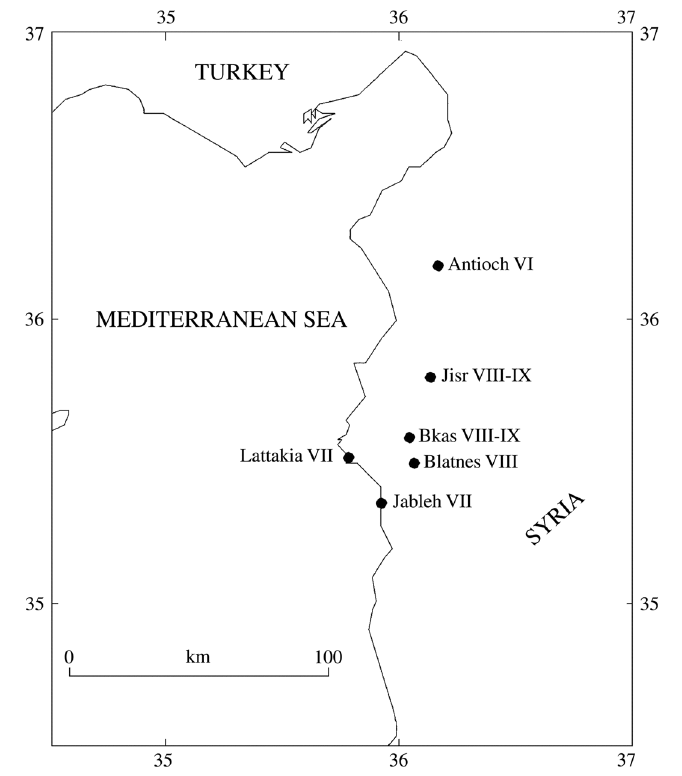
Fig. 17. Map of intensity distribution for December 29, 1408